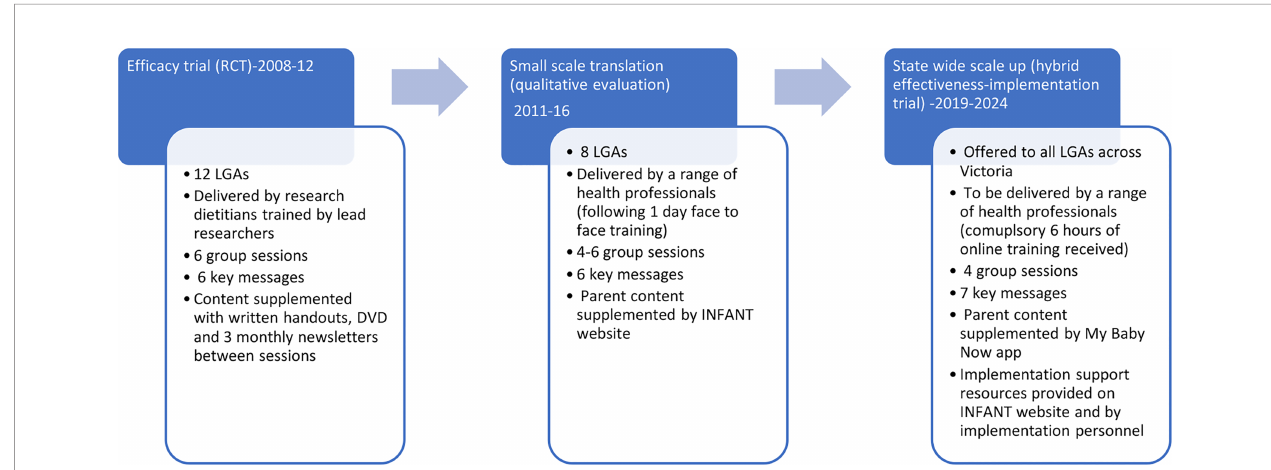
FIGURE 1 | Evolution of INFANT program from ef fi cacy testing to state wide scale